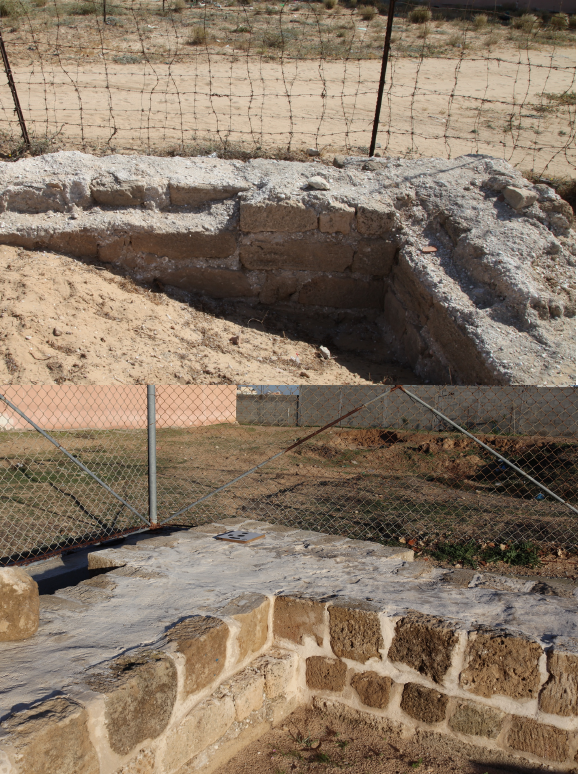
Figure 6. The same angle of a ruined building in 2012 and